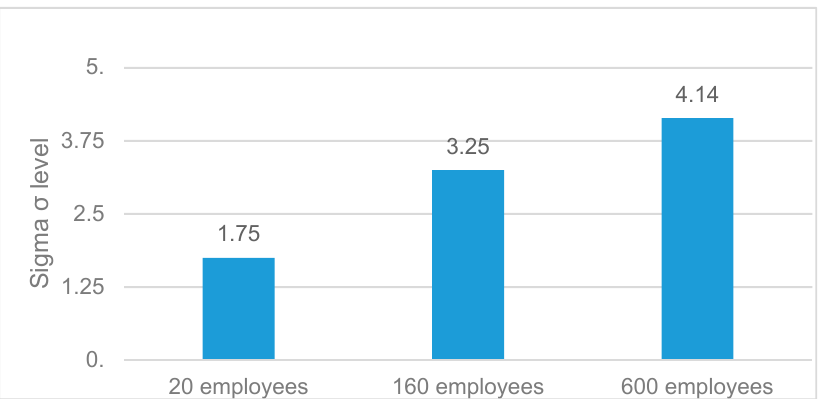
Figure 1. Comparative analysis of the Sigma production process performance of the studied companies against years of experience and firm size.